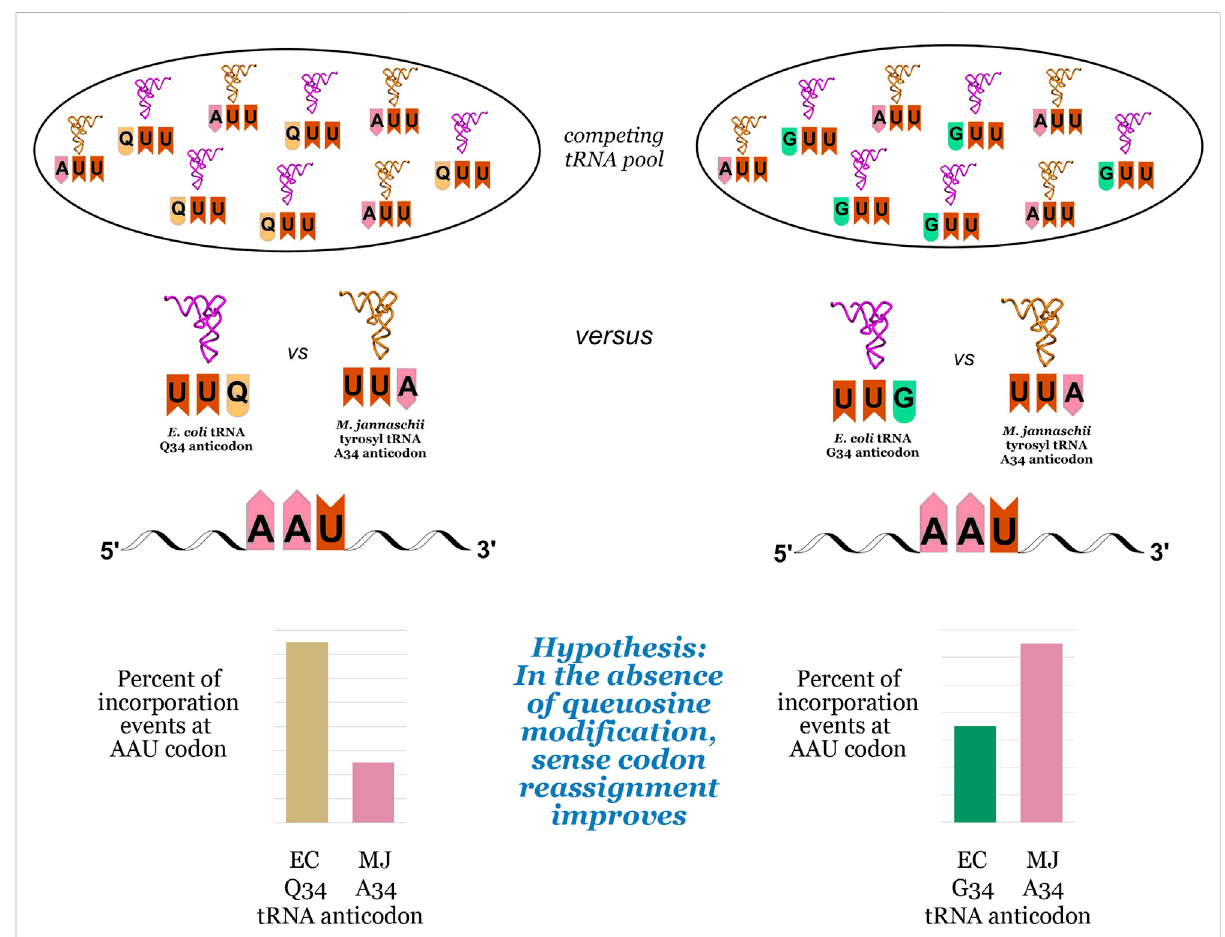
FIGURE 2 CompetitioneventsfordecodingNAUcodonsin E.coli ,usingtheasparagineAAUcodonasanexample.ThepoolofcompetingtRNAsincludes theorthogonal M.jannaschii tRNAaminoacylatedwithtyrosineandtheendogenoustRNAs witheitherqueuosine(Q)atposition34intheanticodon (left) or guanosine (G) at position 34 in the anticodon (right). The pair of bar graphs at the bottom of the fi gure illustrate the hypothesis that an orthogonaltRNAwouldmoreef fi cientlycompeteagainstG34endogenoustRNAsthanQ34endogenoustRNAs,leadingtoincreasedef fi ciency of sense codon reassignment